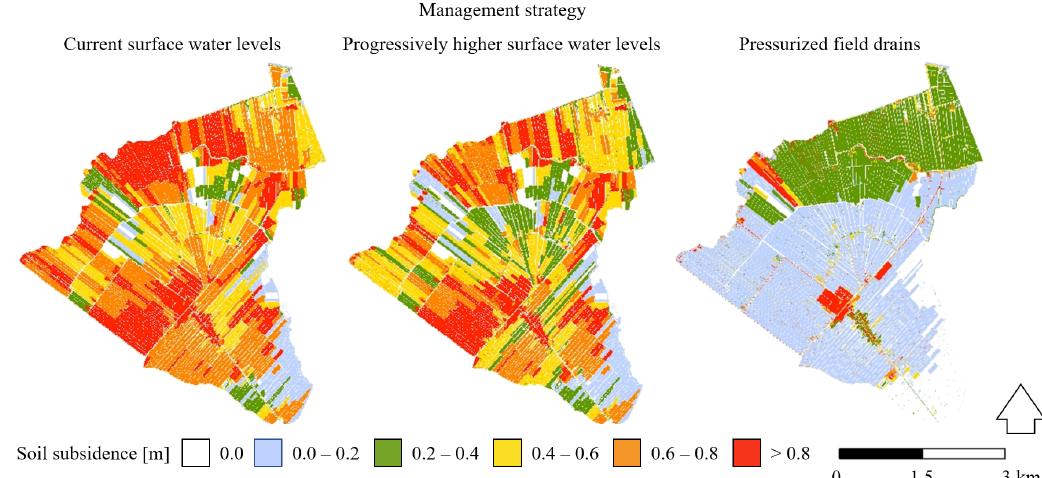
Figure 1. Cumulative soil subsidence in 2019–2100 in the research area resulting from the three management strategies.